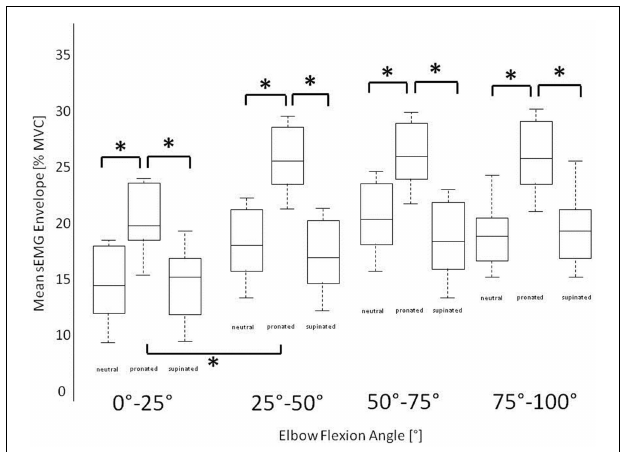
FIGURE 3 | Stepwise mean normalized sEMG amplitude of brachioradialis in three different hand positions in intervals of 25 ◦ of elbow flexion joint angle showing statistical significant differences in pronated hand position in comparison to neutral and supinated hand